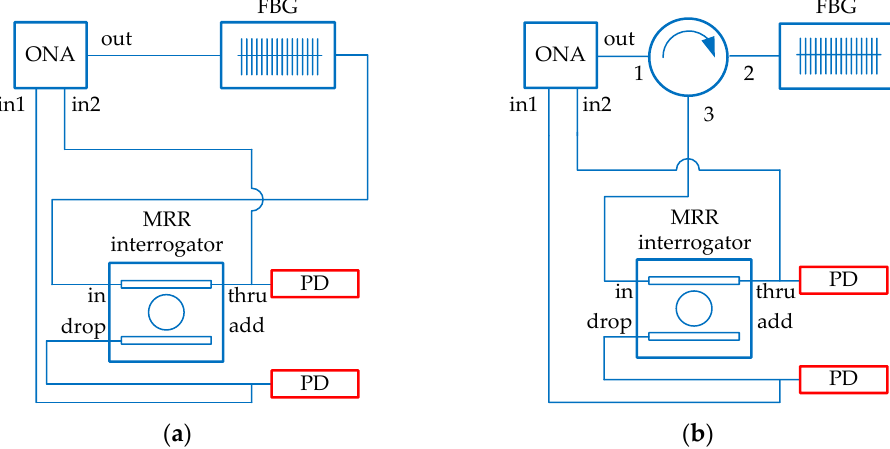
Figure 14. The simulation schemes of FBG interrogation: ( a ) by analyzing the transmitted light; ( b ) by analyzing the reflected light. Numbers 1 − 3 denote the order of the circulator’s ports. Figure 15a,b show the interrogator drop port transmission spectra and demonstrate how the transmission changes depending on the shift of the Bragg wavelength. The simulated relative power at the drop port of the interrogator versus the resonant wavelength of the FBG is provided in Figure 15. ( b ) Figure 15. The combined transmission spectra at the interrogator drop port depending on the Bragg wavelength of the FBG: ( a ) for the scheme that analyzes the transmitted light; ( b ) for the scheme that analyzes the reflected light.